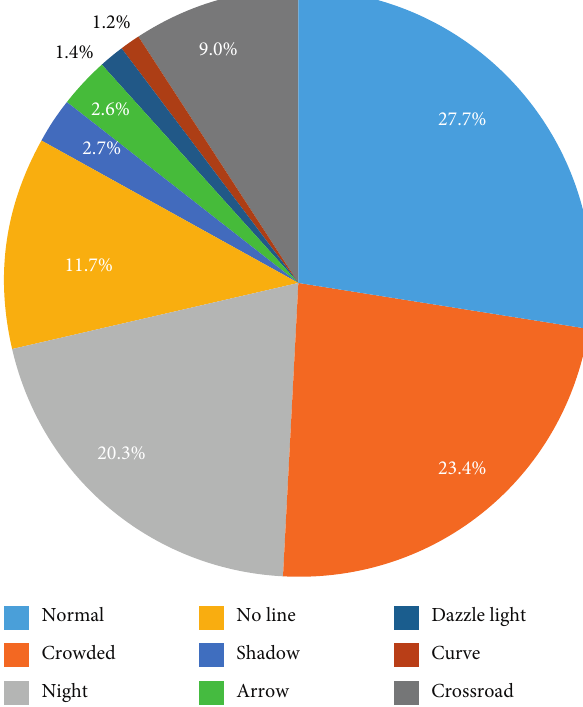
Figure 6: The proportion of different situations in CULane dataset